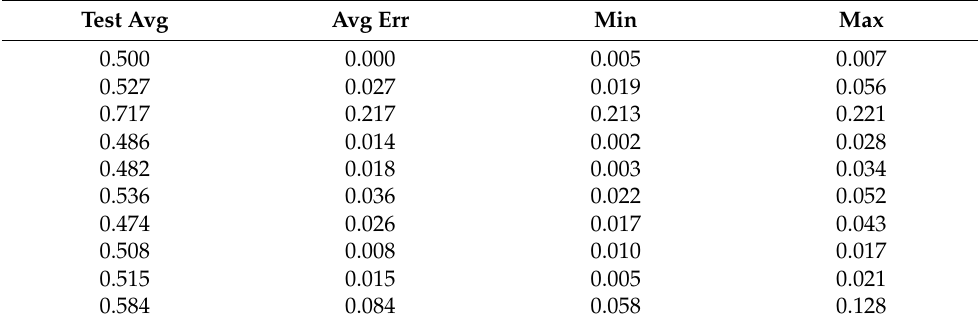
Table A8. Set 1, trials 1–10 data (average actual PR values).